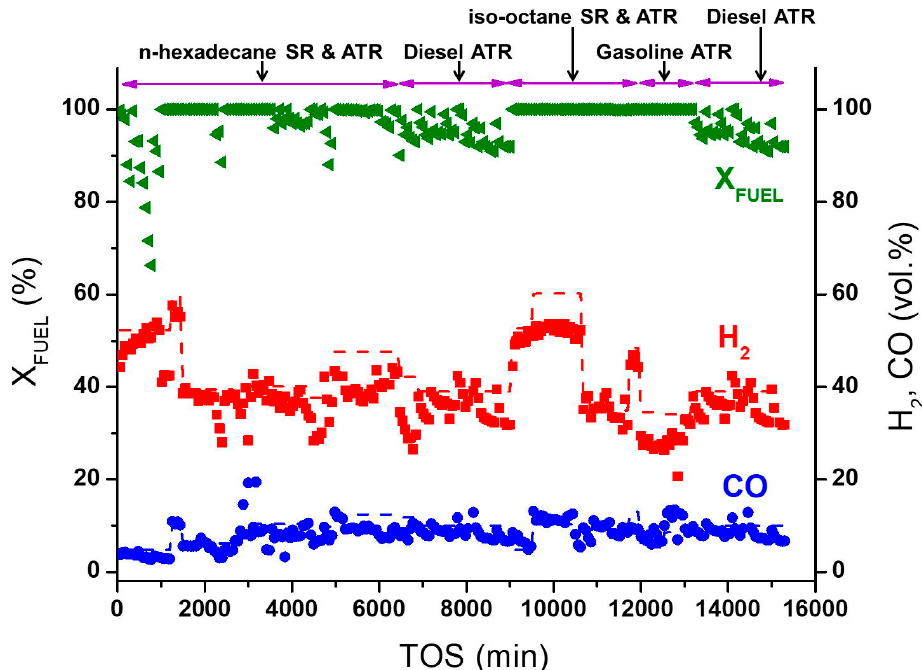
Figure 14. Fuel conversion (X FUEL ), H 2 and CO concentrations (dry basis) as a function of time on stream during SR and ATR of different fuels. Points—experimental data, dashed lines—equilibrium concentrations [93].